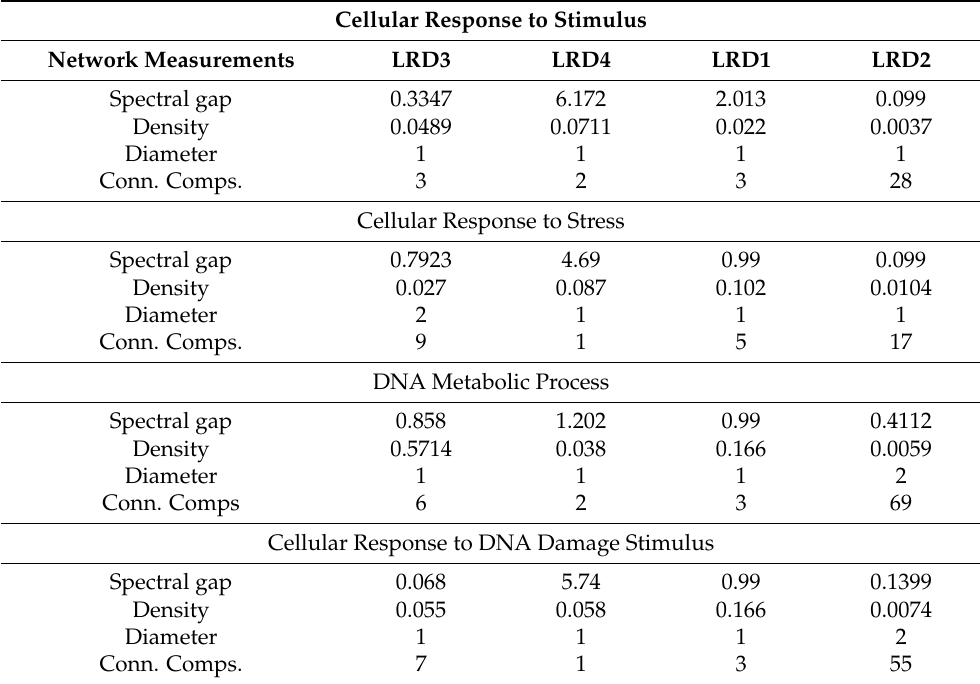
Table 5. Network measures for the subnetworks for low radiation dose DDR processes.